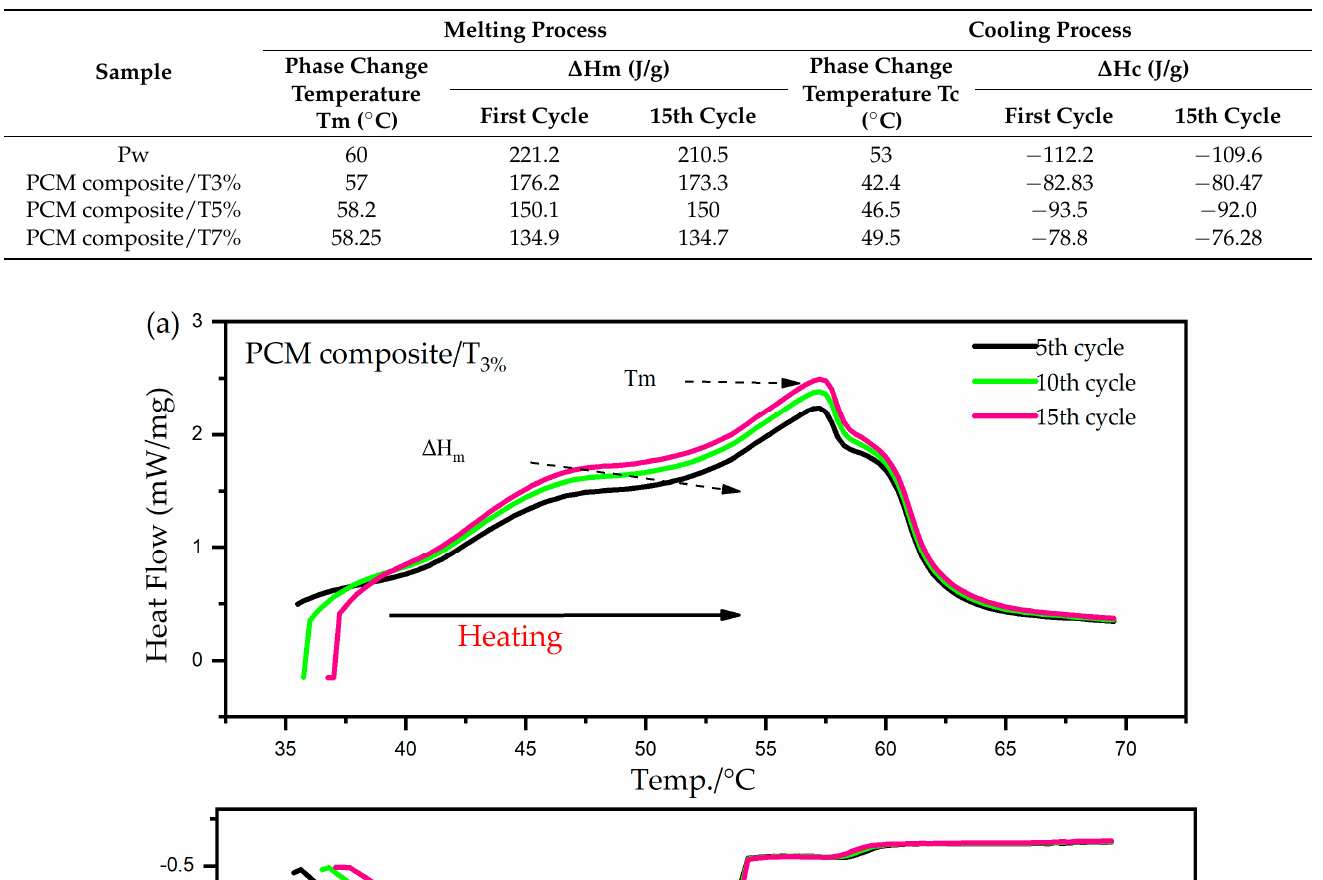
Table 5. Melting and cooling points provided by PW and composites and thermal cycling properties of melting latent heat ( Δ Hm) and cooling latent heat ( Δ Hc) .